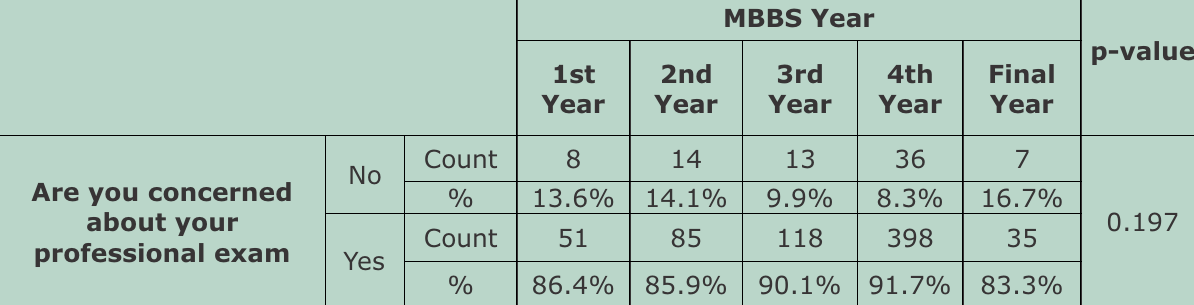
Table-V: Prevalence of Students' Concern during pandemic according to MBBS